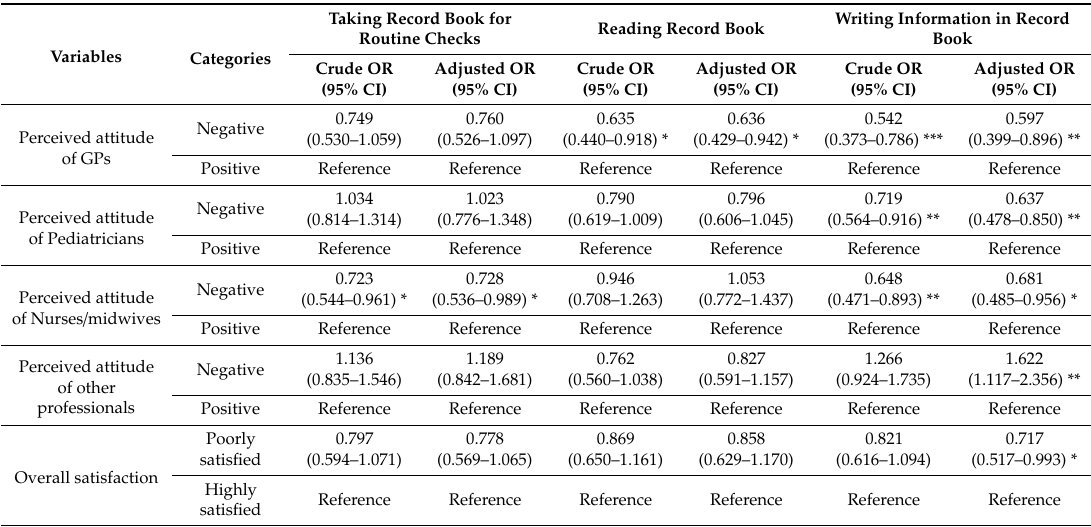
Table 5. Logistic regression examining predictors of parent engagement with child health home-based